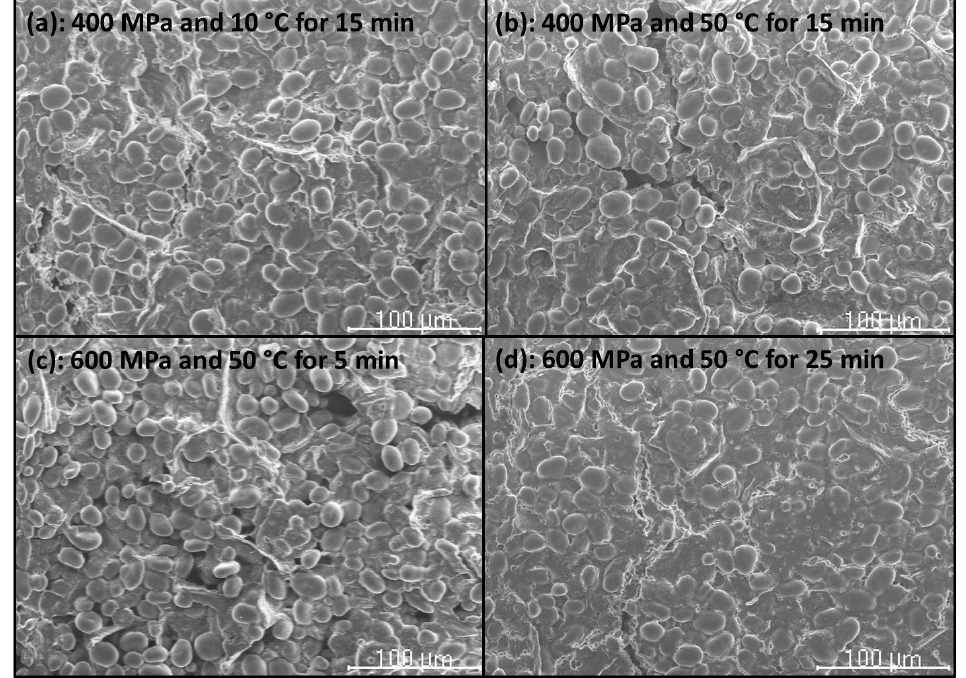
Figure 10. Scanning electron micrographs of pressurized CF in powder form at (300×) magnification: ( a ) CF after pressurization at 400 MPa and 10 °C for 15 min, ( b ) CF after pressurization at 400 MPa and 50 °C for 15 min, ( c ) CF after pressurization at 600 MPa and 50 °C for 5 min, ( d ) CF after pressurization at 600 MPa and 50 °C for 25